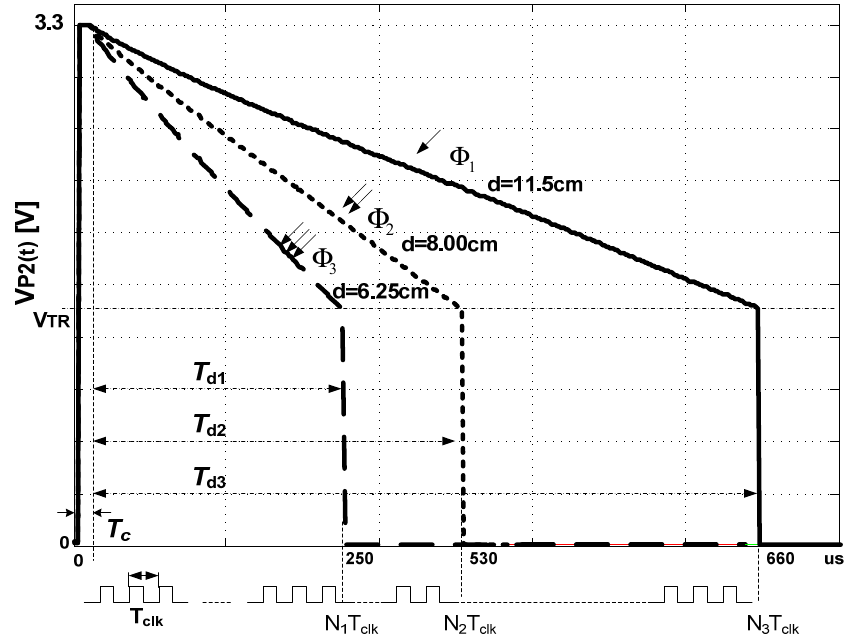
, with corresponding decay times T i